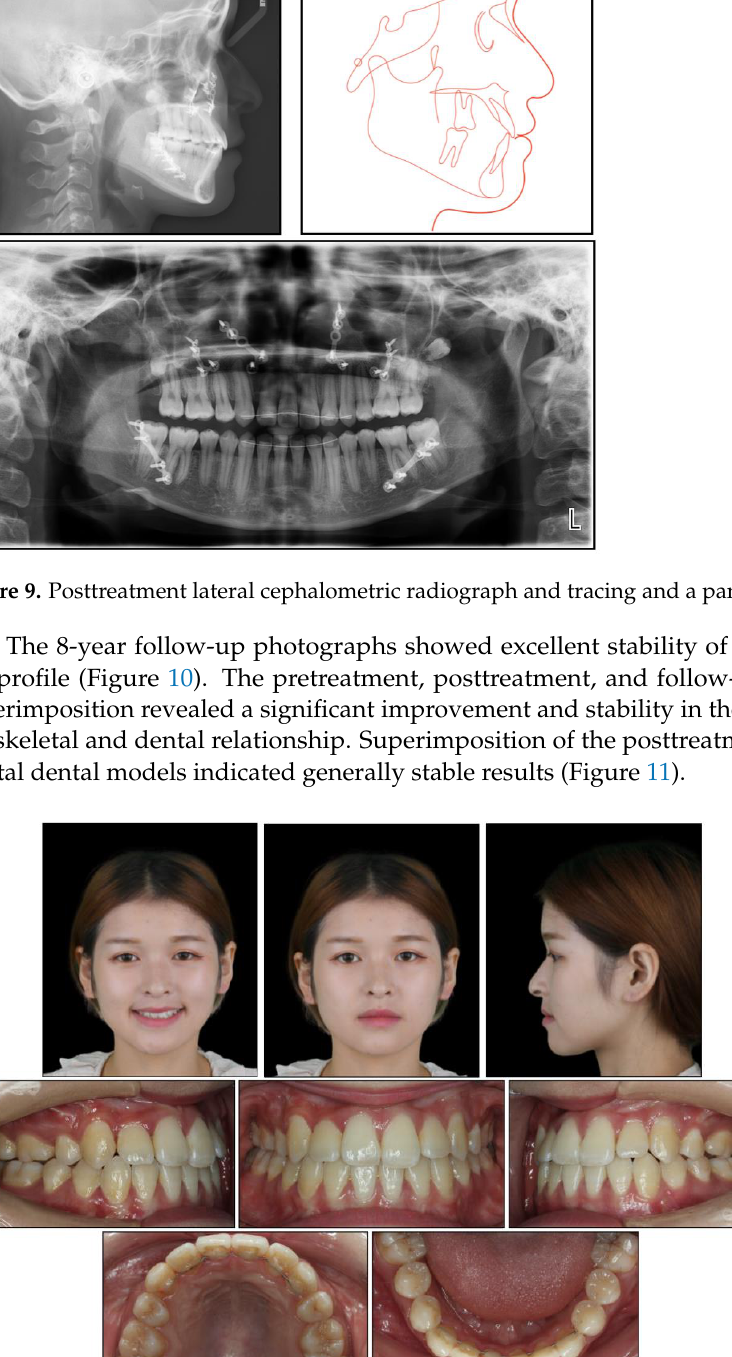
Figure 11. ( A ) Superimposed cephalometric tracings: pretreatment (black), posttreatment (red), and 8-year follow-up (green). ( B ) Superimposition of the posttreatment and retention digital dental models. 3. Discussion Treatment plans for nongrowing patients with skeletal class III malocclusion are var- ied, including sole orthodontic treatment for dental camouflage or combined orthodontic- orthognathic treatment, including single or double-jaw surgery and genioplasty [11]. Johnston et al. reported that bimaxillary surgery was 3.4 times more likely to fully correct the ANB angle than mandibular surgery [12]. Previous studies have shown that maxillary advancement was stable, while large mandibular setback was a risk factor for relapse due to its habitual mandibular forward movement and prolonged growth. Double-jaw sur- gery, including bilateral sagittal split osteotomy and maxillary advancement, is the most